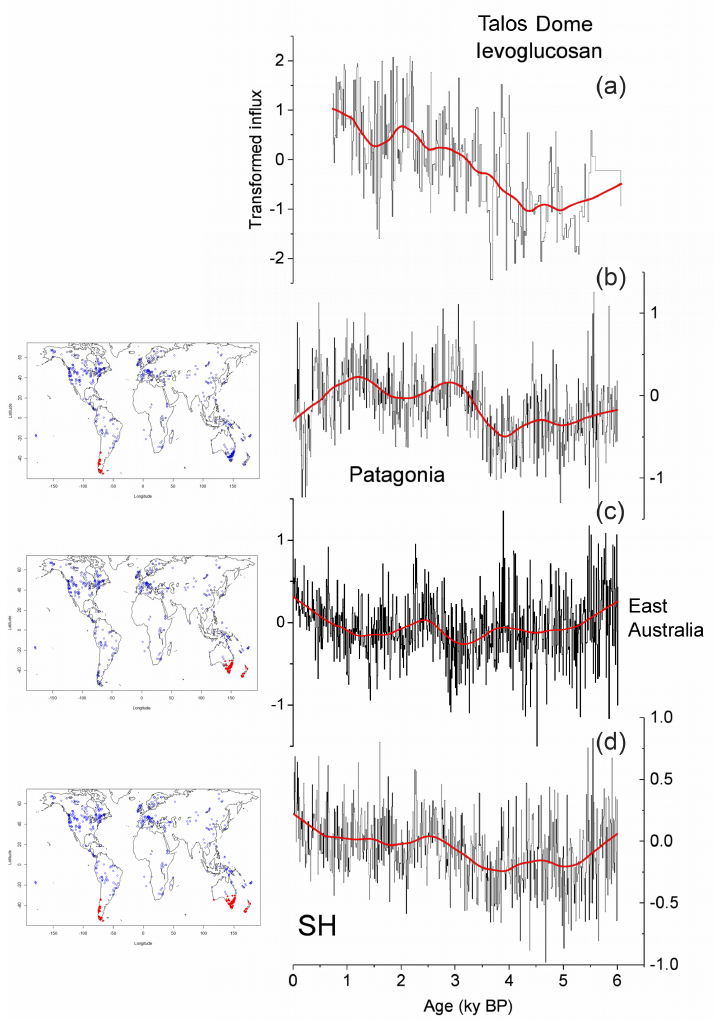
Figure 3. Box–Cox-transformed levoglucosan influx and charcoal synthesis (bins = 20 years) from Patagonia, eastern Australia and Southern Hemisphere synthesis from the GCD. LOWESS smoothing (in red) with SPAN parameters 0.2. Red dots on the map indicate the location of the charcoal